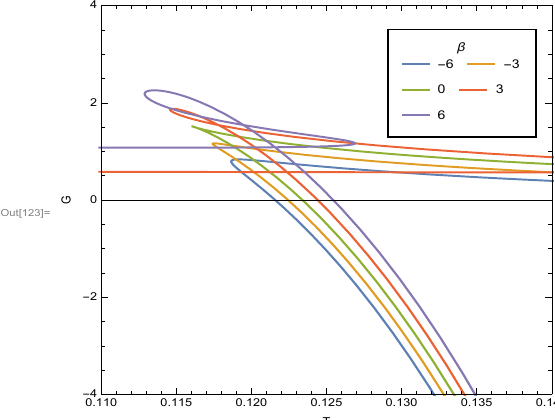
Figure 2. The black hole Gibbs free energy with respect to temperature. The parameters are n = 5, α = 2, a = 0.2, λ = −